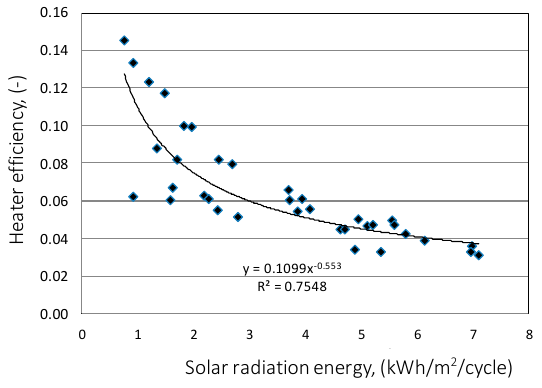
Figure 31. Efficiency of the PCM accumulator depending on the amount of usable energy.